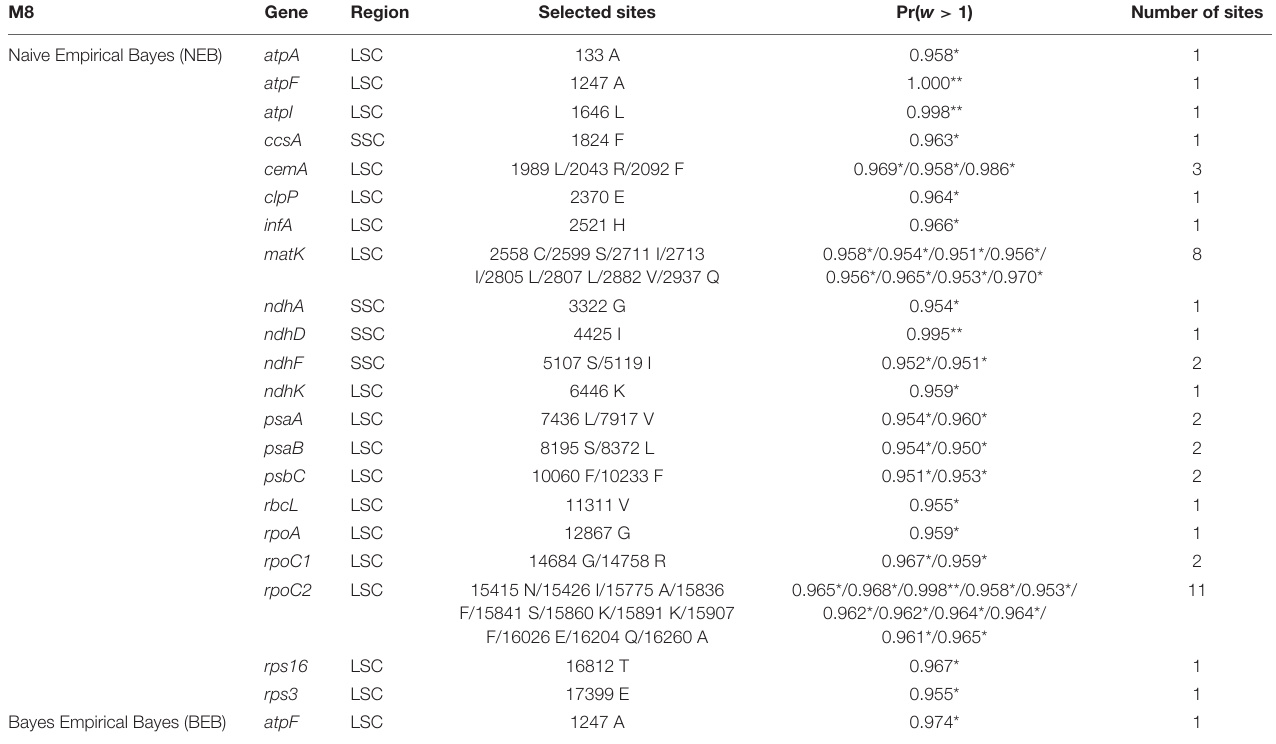
Bayes Empirical Bayes (BEB) atpF The level of significance is indicated by the number of “*”, where “*” represents significant, and “**” indicates highly significant.